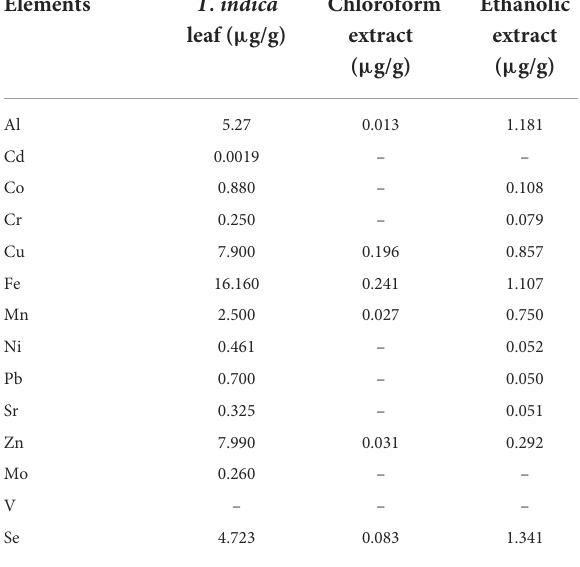
TABLE 5 Elements in T. indica leaf and leaf extracts (38).